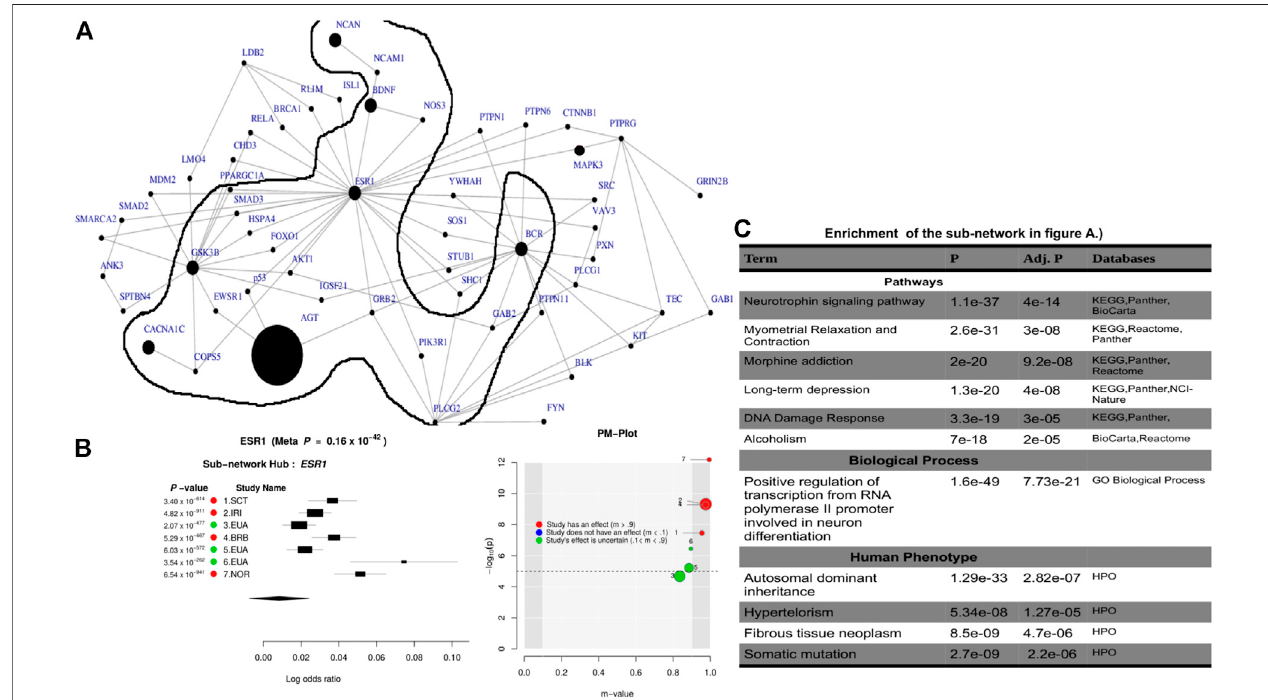
FIGURE 3 | Combined statistical outcomes at the subnetwork level, explaining causality relationship between the simulated phenotype and population variation based on 7 independentGWAS datasets from European bipolar cohorts. (A) The top signi fi cant meta-analysis-based sub-network where the size of anode denotes its statisticalsigni fi cancefromsmalltolargeandlargesizednodeareassociatedgenesorgenesinteractingwithknownBipolargenes. (B) Forestplotofthegene-hub from the top meta-analysis sub-networks in (A, C) Enrichment analysi based on pathways, biological process and human phenotype associated to the top signi fi cant meta-analysis-based sub-network in (A)